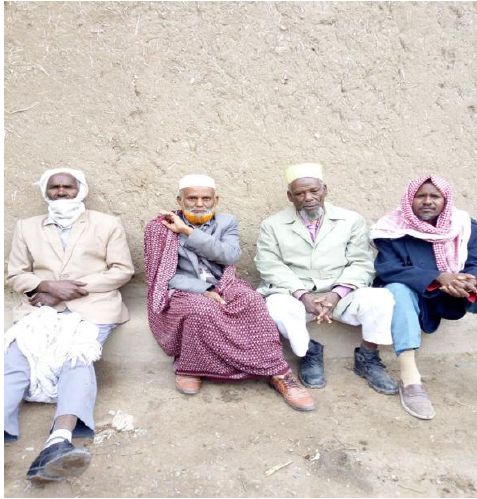
Figure 10. Community elders (Social Group). Amudde, 27 January 2020. Photo, Author. When I asked Haji Gammachu Tufaa (left) and his group (left to right: Suleiman Jibril, Fayye Jirruu, and Mohammad Qumbii) in Amudde, (1) Has someone died you have heard of, or animals, related to Lake Qooqa, and what is the